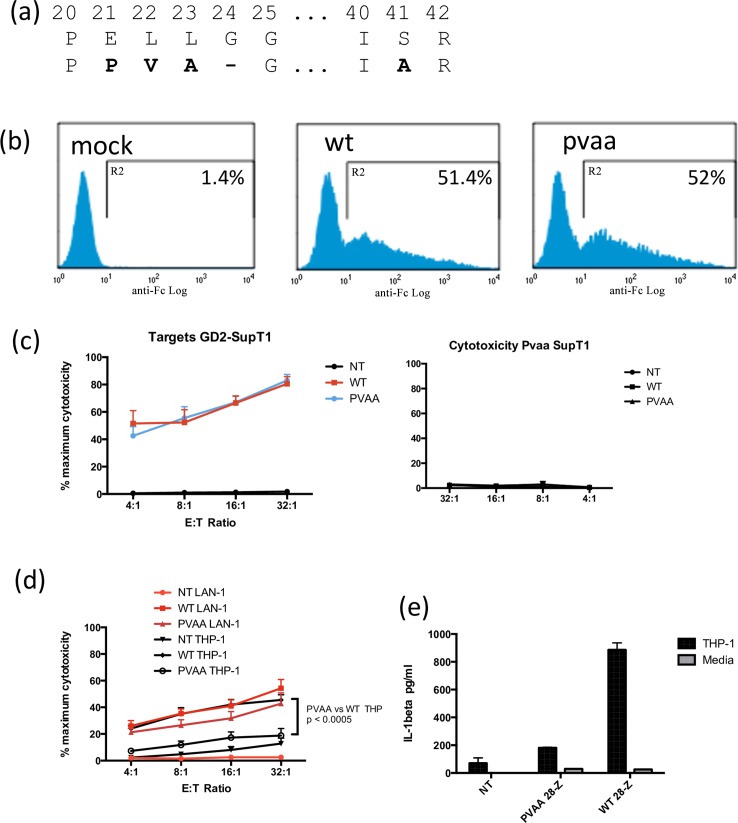
Removal of FcR binding motifs in IgG1 spacer.(a) amino acid sequence of the wild type (top) and mutated (PVAA) CH2 regions responsible for FcγR binding. (b) flow staining with anti-Fc antibody to show comparable level of expression of receptor with or without the PVAA mutation. Identical CARs with and without PVAA were compared side by side in terms of cytotoxicity against GD2 engineered SupT1 and GD2 negative wild type SipT1 cells (c), cytotoxicity against GD2 positive Lan1 cells and FcRγ positive THP-1 cells (d), and IL-1β release on culture with THP-1 cells (e). Data shown as means +/-SEM from 4 independent experiments with different donors.